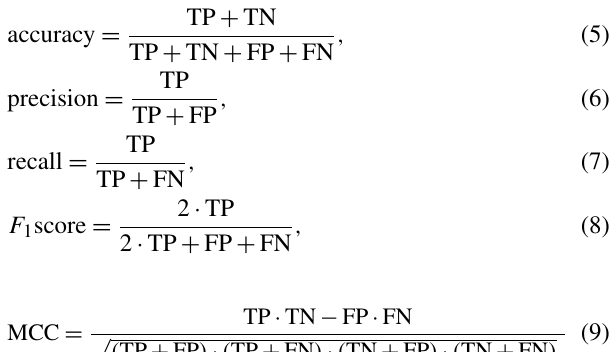
coefficient was selected as the optimal model. To avoid over- fitting and maintain high calculation efficiency, the L2 regu- larization method was selected for each model by setting the parameter “penalty = ‘l2’